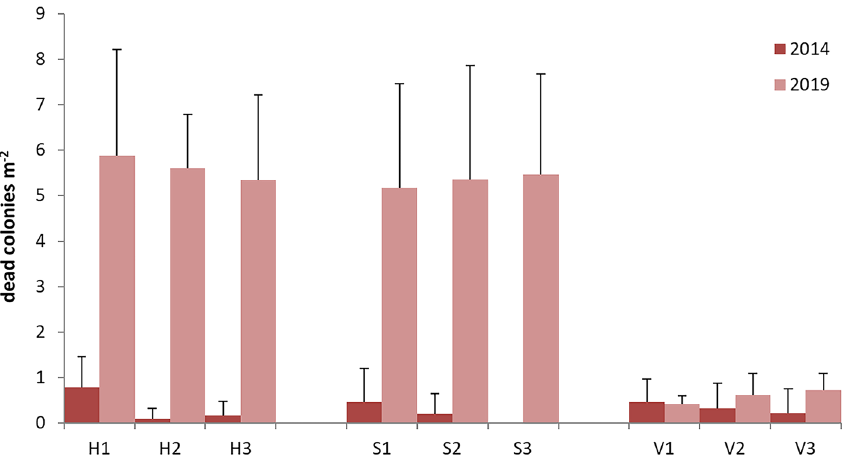
Figure 2. Mortality (mean ± standard error) of Paramuricea clavata during 2014 and 2019 at Tremiti Archipelago, with three replicates per area characterized by horizontal (H), sub-vertical (S) and vertical (V)